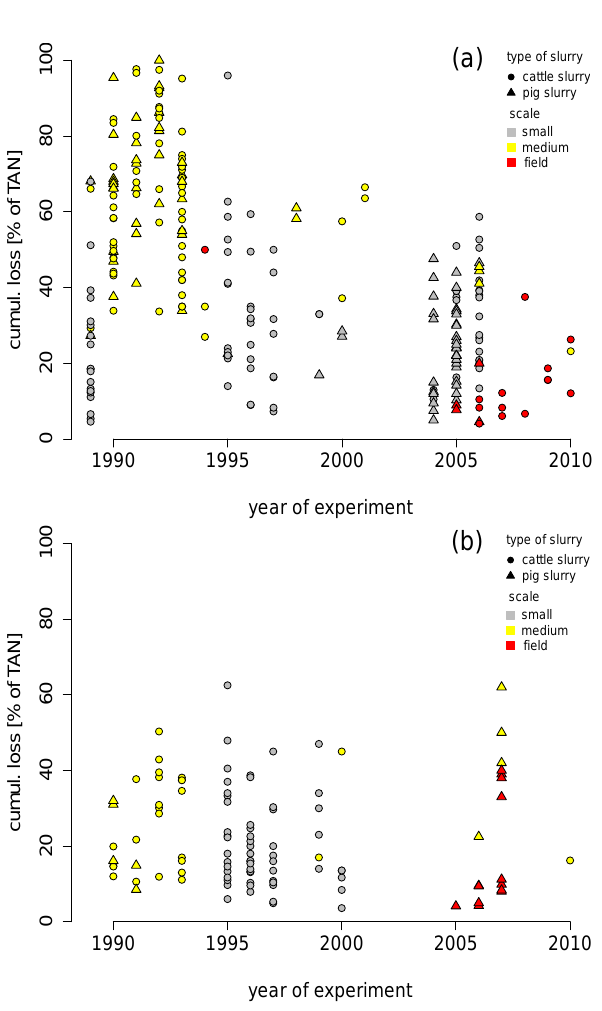
Fig. 1. Reported NH 3 EFs for (a) splash plate application and (b) band (near-surface) spreading, plotted vs. the year of measurement. Circles show trials using cattle slurry and triangles represent pig slurry trials. A colour code is used for three classes of measurement plot scale (note that the resultes of Balsari et al. (2008) are excluded from this figure as no measurement year is